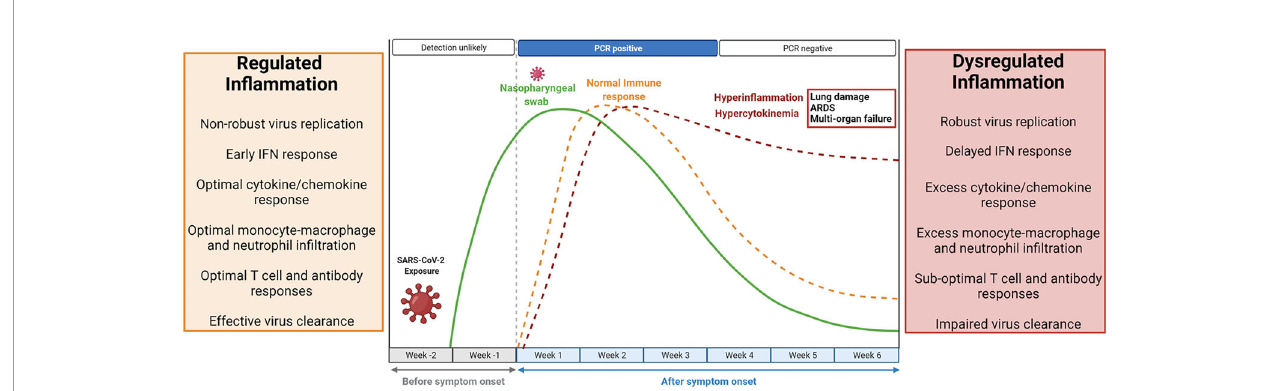
FIGURE 1 | Kinetics of SARS-CoV-2 replication and the antiviral immune response. The median incubation period of SARS-CoV-2 is 4-5 days, and symptoms usually start appearing by 11.5 days. Within a week of symptoms appearing, viral load reaches its peak and becomes detectable in RT-PCR tests. A non-robust viral replication is associated with a regulated and protective immune response. Early IFN (interferon) response, optimal monocyte-macrophage and neutrophil in fi ltration, optimal secretion of pro-in fl ammatory cytokines and chemokines, and optimal lymphocyte responses result in effective viral clearance. The in fl ammatory response resolves within 4-5 weeks after symptom appearance, viral particles go below the detection limit, but viral RNA may persist in low amount, and the person recovers. However, robust SARS-CoV-2 replication may lead to delayed IFN response, excess monocyte-macrophage and neutrophil in fi ltrations, sub-optimal lymphocyte response, and impaired viral clearance. The resulting aberrant in fl ammatory response known as hyperin fl ammation is associated with excessive secretion of pro- in fl ammatory cytokines and chemokines (hypercytokinemia) and accumulation of in fl ammatory cells in the lungs. Hyperin fl ammation and hypercytokinemia may lead to diffused alveolar damage (DAD), acute respiratory distress syndrome (ARDS), and multiorgan failure. Created with